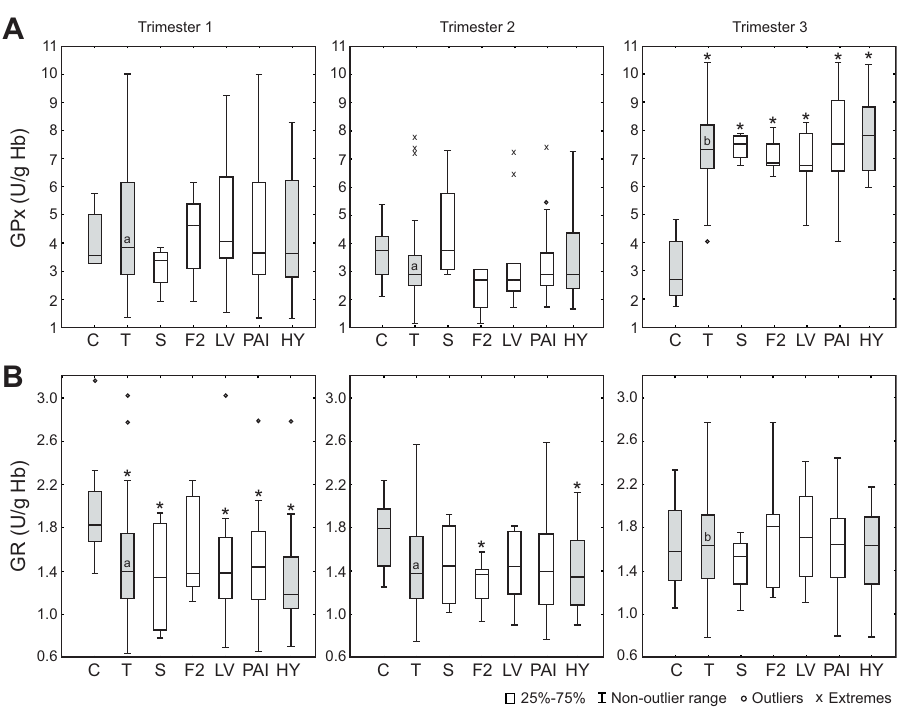
Fig 2. The activities of glutathione peroxidase (GPx) and reductase (GR) in erythrocytes in different trimesters. ( A ) GPx activity. ( B ) GR activity. C–control (n = 10 for each trimester); T–thrombophilias (all; n = 56); S–protein S deficiency (n = 4); F2 – F2 gene mutation (n = 6); LV–Factor V Leiden mutation (n = 13); PAI– PAI -1 polymorphism (n = 31); HY–thrombophilic pregnancies burdened with hypertension (n = 20). Boxes represent the median and the 25 th and 75 th percentiles; whiskers represent the non-outlier range; circles–outliers; x—extremes. � —Statistically different compared to control (p < 0.05). Different trimesters in thrombophilic pregnancy not sharing a common letter in the box are significantly